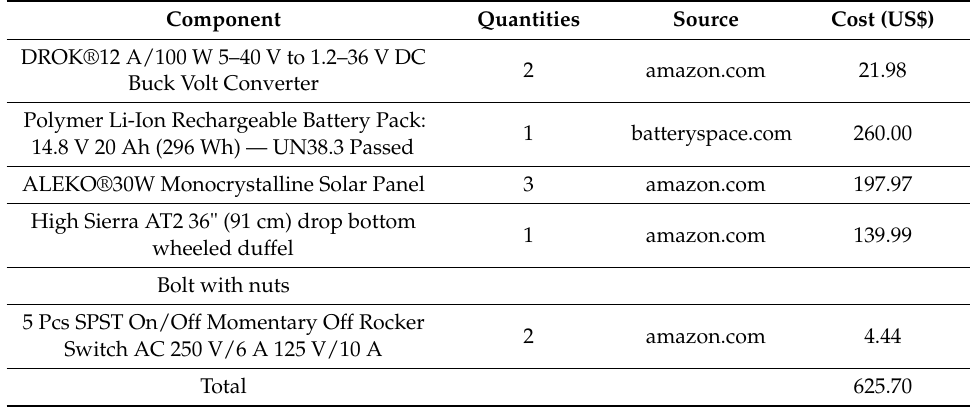
Table A1. Bill of materials and material specification of the components and